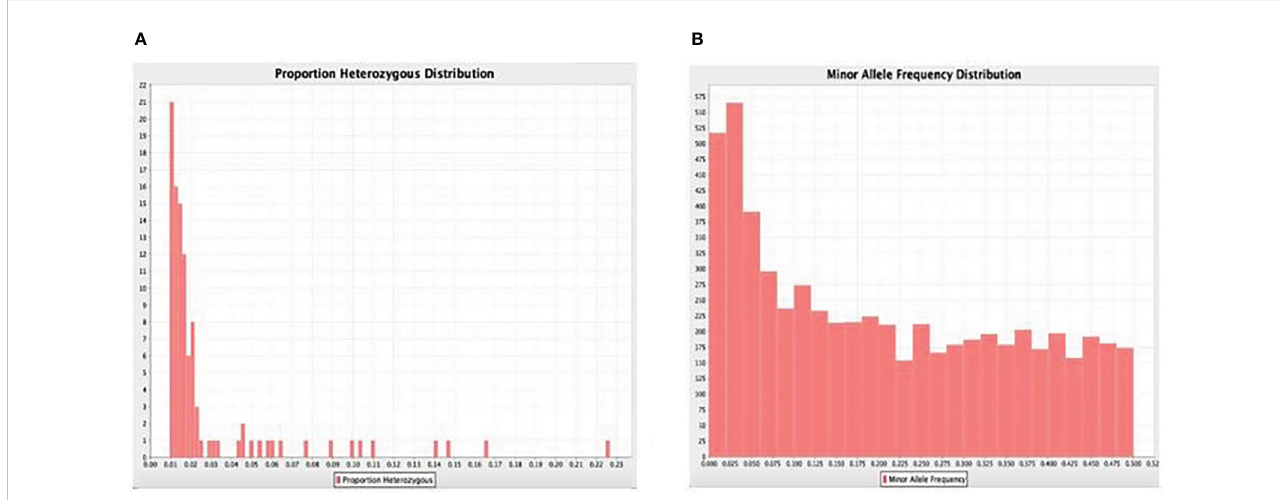
FIGURE 2 (A) Gene summary showing the frequency proportions of the heterozygosity frequency and (B) minor (rare)